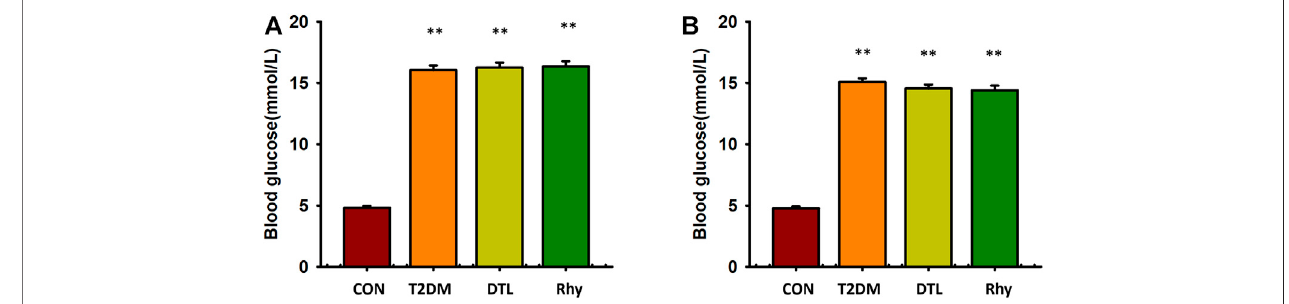
FIGURE 2 | Effect of rhynchophylline on blood glucose. (A) The bar graph showed the fasting blood glucose levels of mice in the CON group, T2DM mice, DTL group and Rhy group before administration. (B) Blood glucose levels measured 2 months after administration. CON:control group mice; T2DM: Type 2 diabetes model